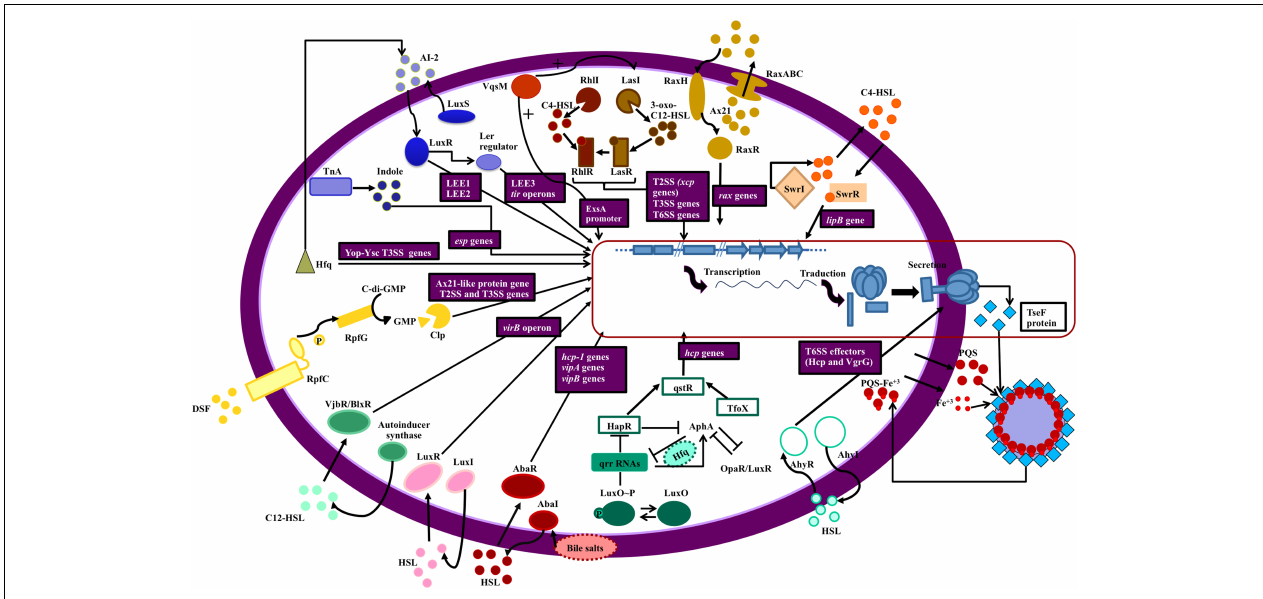
FIGURE 2 | Secretion systems and QS network elements. The figure shows the relationship between QS networks and expression of secretion systems (blue squares). The genes regulated by QS are in purple boxes. Each QS network is represented by a different color. Starting at the top right of the figure: The swr QS system of S. liquefaciens controls the lipB genes of the T1SS (orange); Ax21 (QS effector) and QS system Rax regulate RaxABC TOSS (T1SS) in gram negative bacteria (ochre); QS (RhlIR and LasIR) regulates expression of T2SS, T3SS, and T6SS in P. aeruginosa (brown); VqsM (an AraC family transcription factor) interacts with the LasIR and ExsA promoters (a master regulator of T3SS) in P. aeruginosa (dark orange); T2SS is regulated by LuxS/LuxI/AI-2 QS in E. coli and indole production by TnA (tryptophanase) regulates esp genes expression (T2SS) in this bacterium (blue); in Yersinia sp. the Hfq chaperone is connected with QS (AI-2) and regulates the Yop-Ysc type III secretion system (T3SS) (green); in Xanthomonas sp. T2SS and T3SS are regulated by DSF (diffusible signal factor) which is a quorum sensing signal (yellow); T4SS ( virB operon) is regulated by VjbR (LuxR like protein) and LuxI in Brucella (turquoise) and Roseobacter (pink), respectively; a connection between Acinetobacter baumanii QS (AbaI/AbaR, controlled by bile salts) and T6SS has been established (maroon); in Vibrio sp. there is a complex network which relates QS (LuxO/HapR/TfoX) with T6SS (aquamarine); AhyRI (a QS network) in Aeromonas sp. and P. atrosepticum is involved in Hcp and VgrG secretion (sky blue) and finally, iron is transported across the cell membrane accompanied by PQS, a quorum sensing signal in P. aeruginosa , and this process depend on Tse a substrate of T6SS, which binds to OMVs (outer membrane vesicles) containing PQS- Fe 3 +